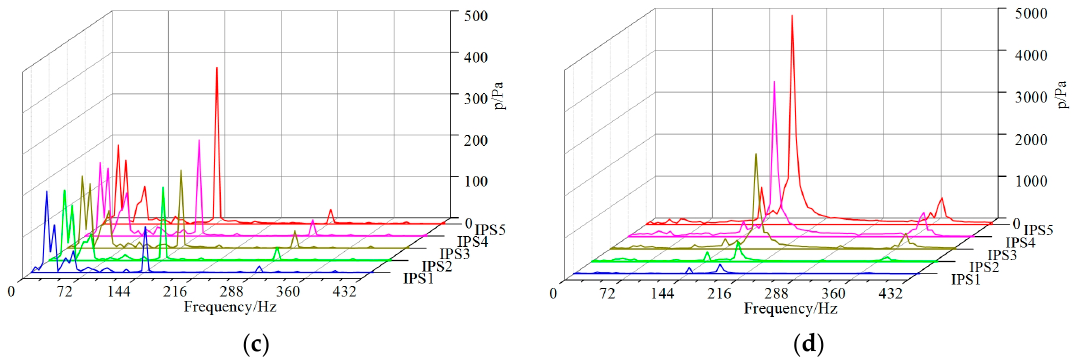
( c ) ( d ) Figure 12. Spectrum analysis of pressure fluctuations on IPS1–IPS5. ( a ) δ = 0.0 mm; ( b ) δ = 0.2 mm; ( c ) δ = 0.65 mm; ( d ) δ = 1.0 mm.